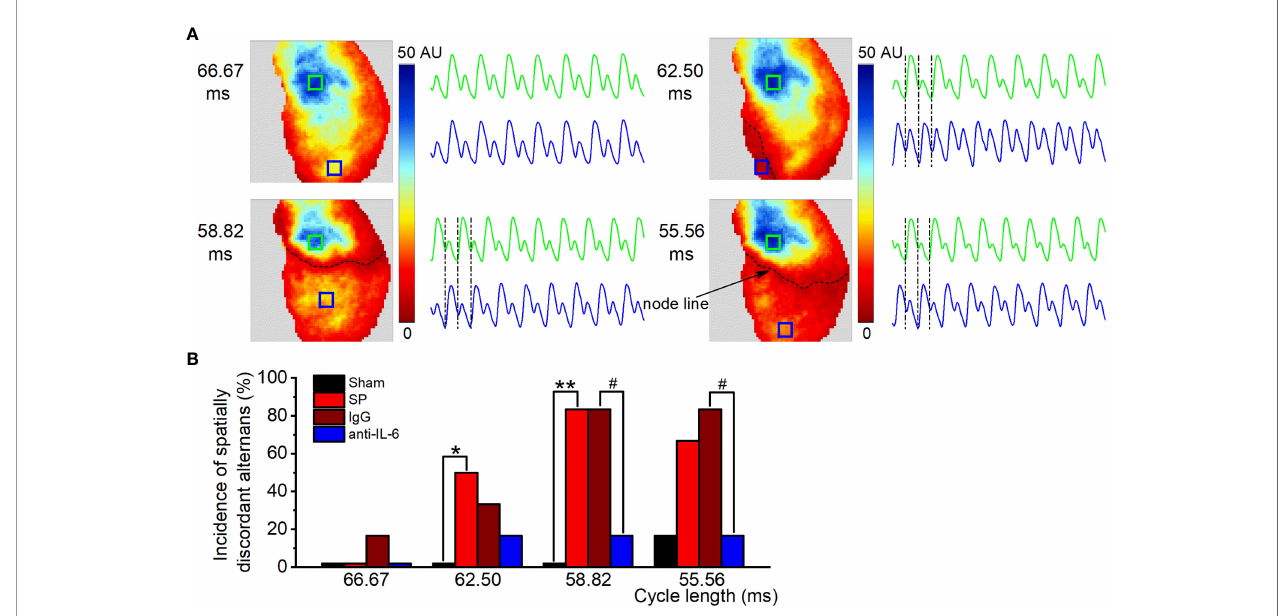
FIGURE 5 | IL-6 neutralization reduces the onset of spatially discordant alternans in SP rats. (A) Maps of atrial CaT alternans (spectral magnitude) and example CaT traces from the corresponding locations in the maps at cycle lengths from 66.67 to 55.56 ms in the SP group, showing spatially concordant alternans at 66.67 ms and spatially discordant alternans (one area is out-phase with one another, accompanied by a node line in black between the two regions) at 62.5 ms, 58.82 ms, and 55.56 ms. (B) Incidence of spatially discordant alternans in the Sham, SP, IgG, and anti-IL-6 groups for each pacing rate. n = 6/group. *P < 0.05, **P < 0.01 vs . Sham; # P < 0.05 vs . IgG, determined by c 2